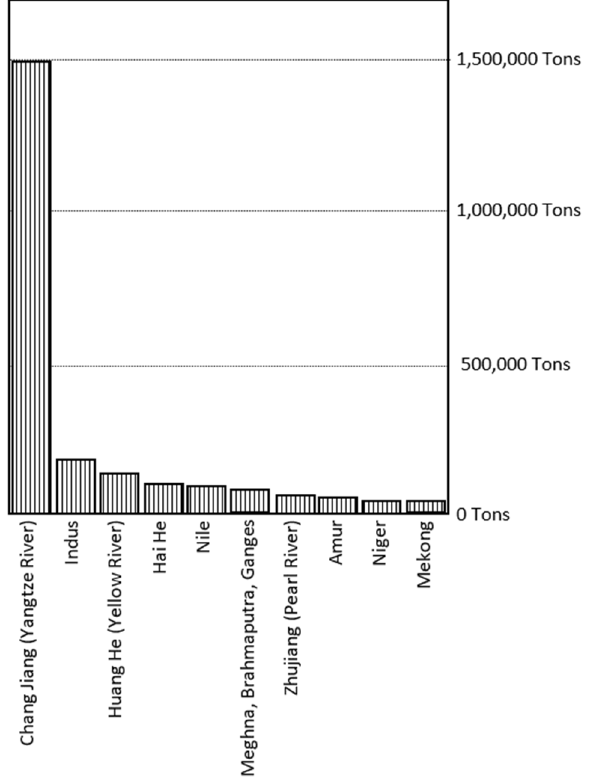
Figure 3. Major river contributing to plastic in oceans [modified from John et al., 2022] [69]. Significant quantities of microplastics have been reported along riverbeds around the world, suggesting that rivers function not just as pathways but also as potential pools of plastic microparticles [72]. Under the influence of changing water currents, due to seasonality, for instance, deposited plastic particles on riverbeds can either return to the water column mobilized by the water flow or stay still settled [70]. On the other hand, floating plastic particles would respond in a different way under the same hydrodynamic conditions (Figure 4). However, deeper research on the diffusion of varied microplastic types in river sediments is scarce.